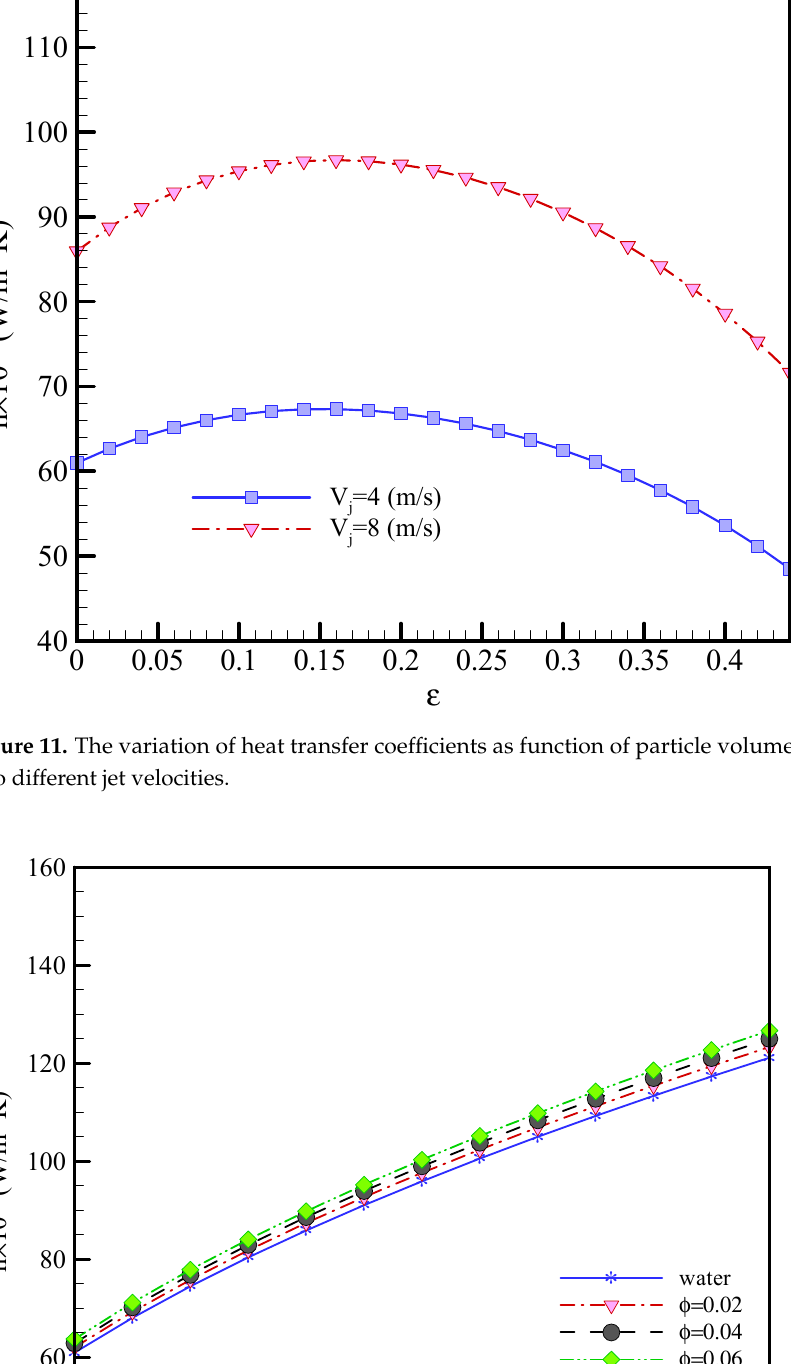
Figure 10. Heat transfer coefficient profiles as function of inlet jet temperature for water and NEPCM slurry with different particle volume fraction (